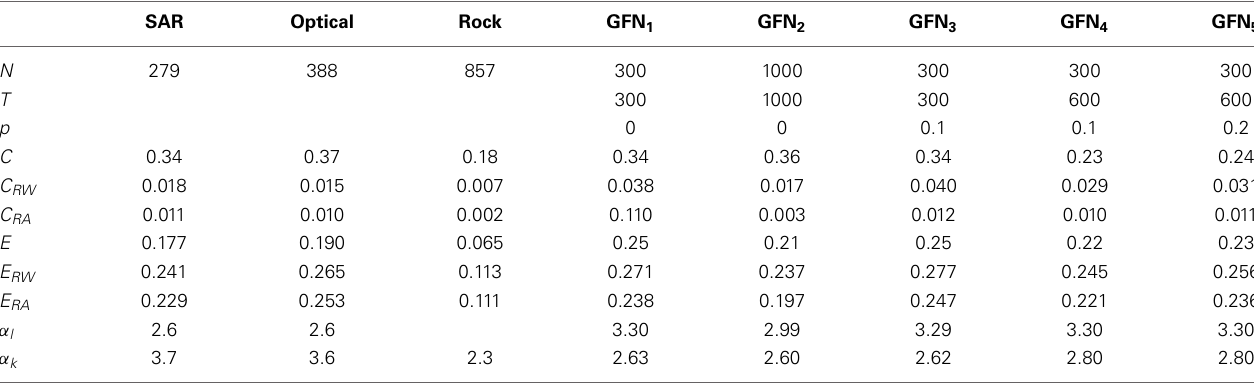
Table 2 | Comparison of average network properties between fracture networks and models. SAR